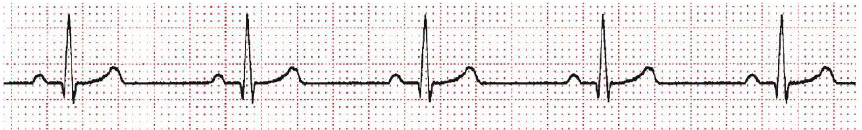
Figure 4. Example of the cropped image for one lead (Normal sinus rhythm, 60 bpm, II lead). At this point, steps B and C were done in B. Binary mask . The extraction of the binary masks has been inspired by the Math- Works Community [25]. Firstly, the image is converted from RGB to HSV. Then, in order to extract the signal from the rest of the image, three ranges of color (from 0 to 1) were chosen for each HSV channel: 0.000 ≤ 𝑝 𝐻 ≤ 0.997; 0.000 ≤ 𝑝 𝑆 ≤ 0.659; and 0.647 ≤ 𝑝 𝑉 ≤ 1.000, where 𝑝 𝐻 , 𝑝 𝑆 , and 𝑝 𝑉 are the values for each channel of the HSV space, within which, the pixels are considered to be part of the signal. The result is a black and white image (one per crop), as shown in Figure 5. Figure 5. Binary mask of the cropped image (normal sinus rhythm, 60 bpm, II lead). After, the signal is thinned (see Figure 6) using the MATLAB function “bwmorph” with the operation “shrink” , which replaces groups of neighboring pixels with a single pixel. Experimentally, it was observed that, in order to reduce noise, the best result was obtained with its parameter set to 2.5, i.e., the number of times the “shrink” operation is performed. Figure 6. Thinned signal image (normal sinus rhythm, 60 bpm, II lead). C. Scale Factor (SF) calculation . The standard ECG leads are printed on graph paper (see Figure 7).